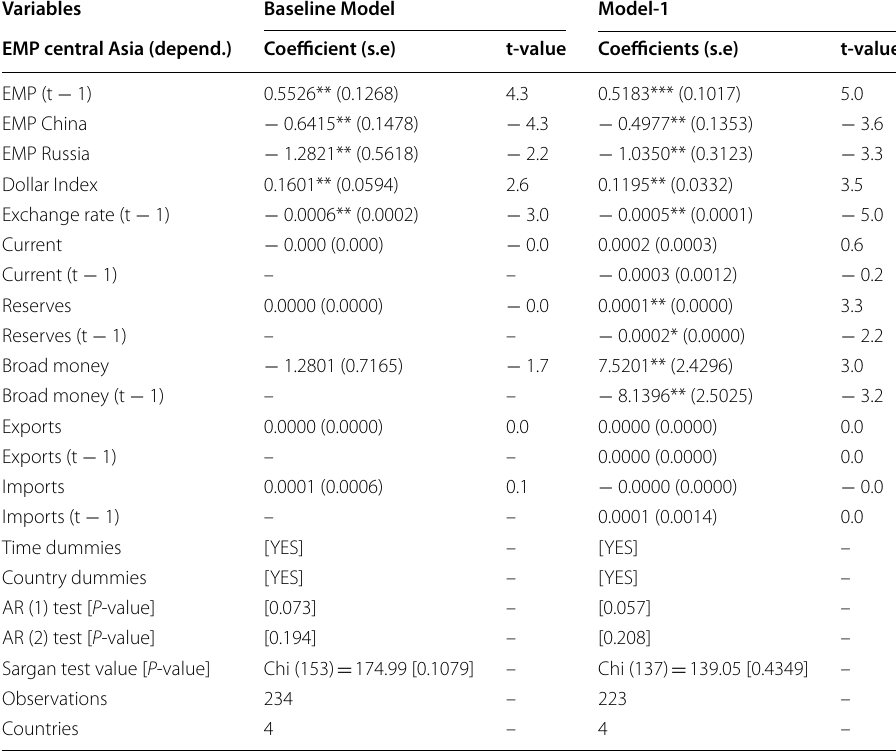
Table 3 System GMM analysis of EMP across central